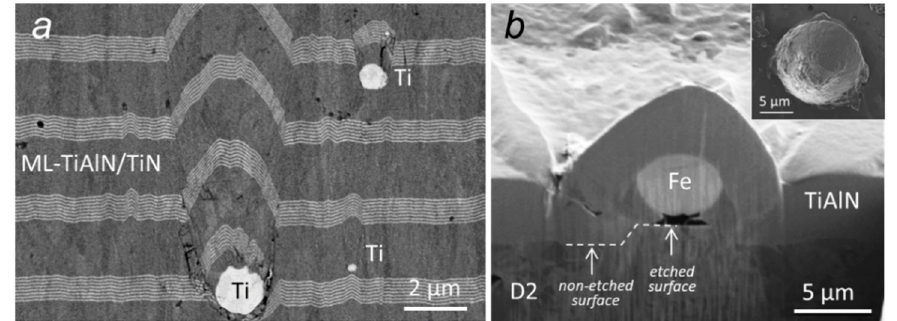
Figure 15. FIB cross-section image of a buried droplet formed in the multilayer TiAlN/TiN hard